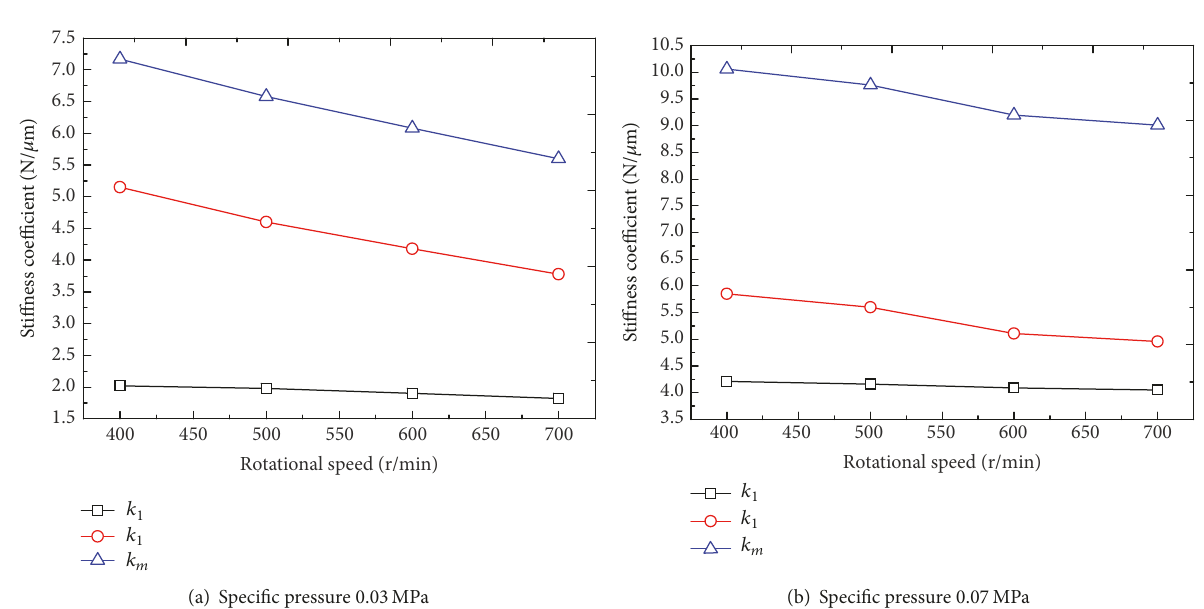
Figure 11: Stiffness coefficient identified at different loads and